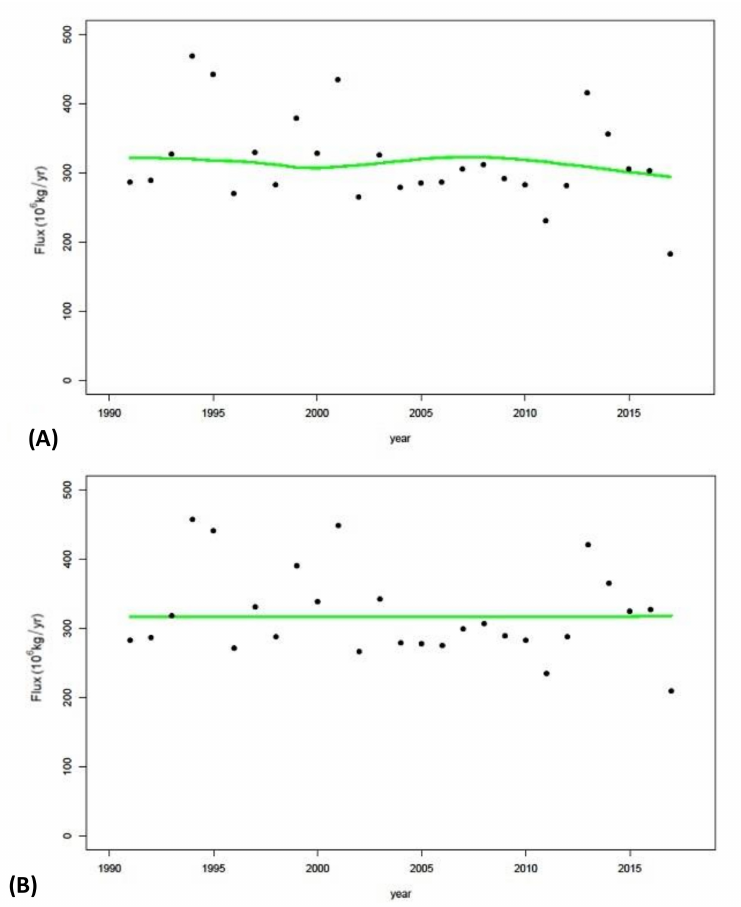
Figure 10. Predicted change in nitrate fluxes for the 1990–2017 period with no random ( A ) and no systematic ( B ) variations for the Rhone